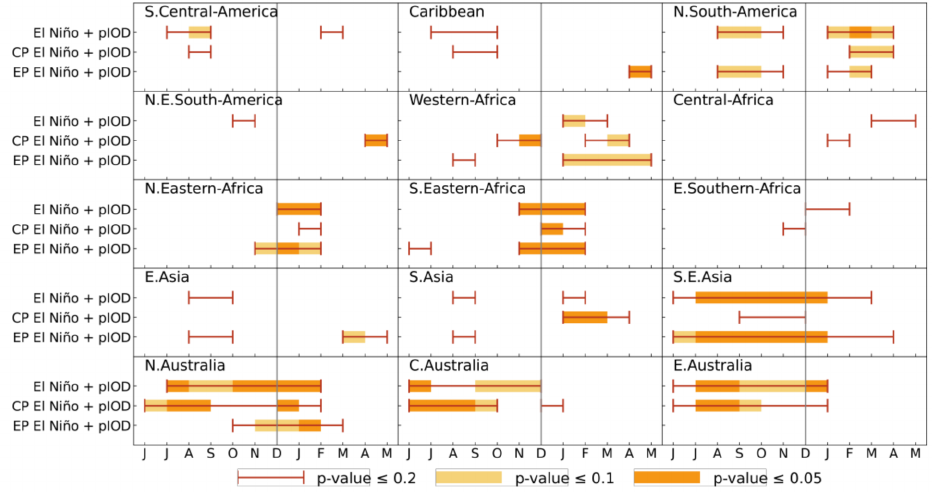
Figure 9. The same as Figure 7, but for comparisons during El Niño + pIOD, CP El Niño + pIOD, and EP El Niño +